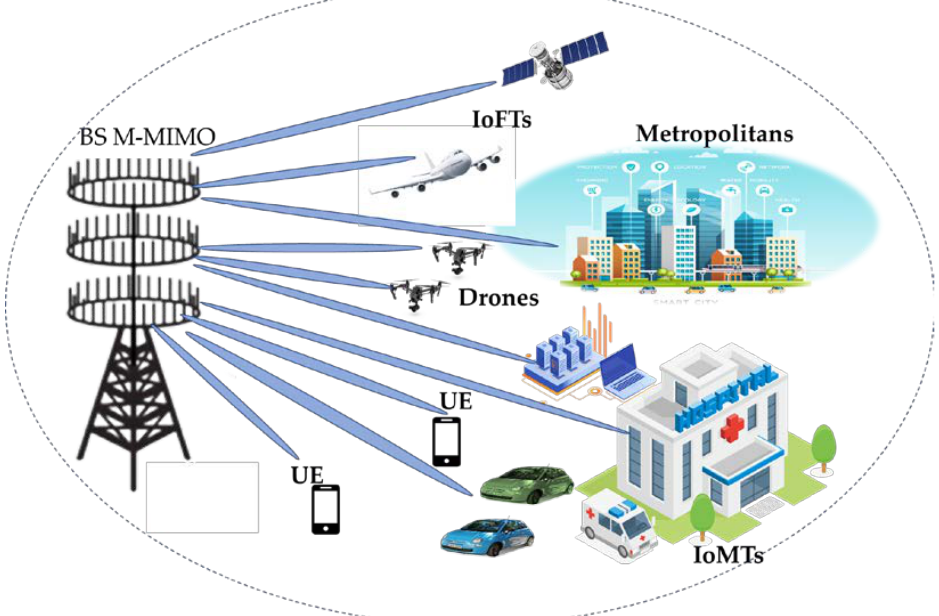
Figure 3. The use of M-MIMO in the HetNet